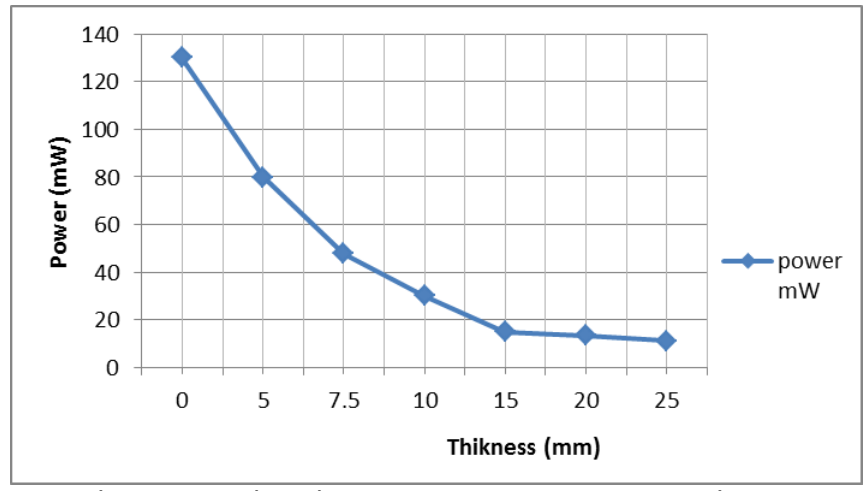
Figure 4: Relationship between laser power and glass